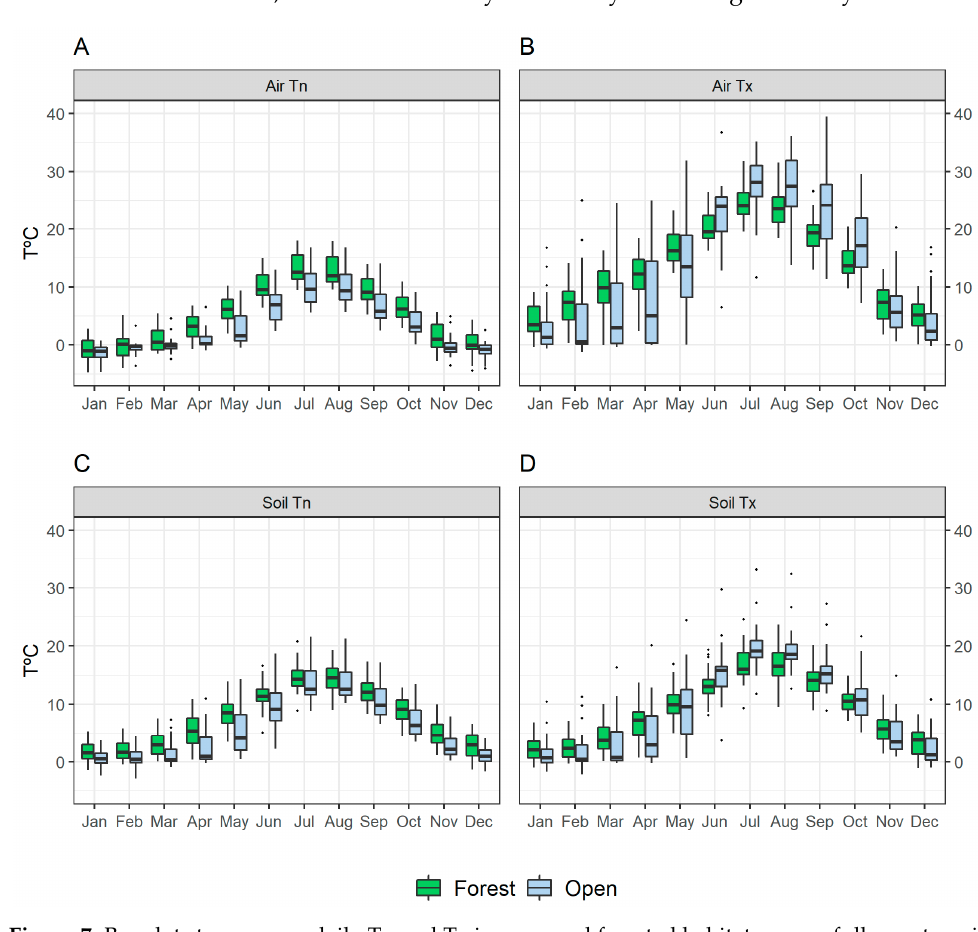
Figure 7. Boxplots to compare daily Tn and Tx in open and forested habitats over a full year-type in the PNOMP, both in the air ( A , B ) and soil ( C , D ).